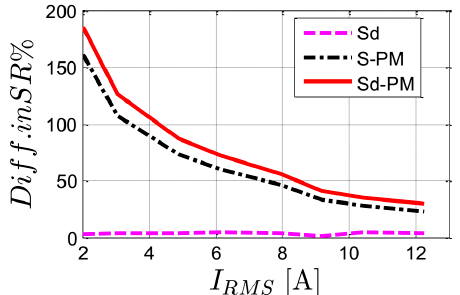
Figure 10. Difference in the saliency factor % ( SR ) as a function of stator current ( RMS ) with respect to the S machine at the optimal current angles and rated speed of the SynRMs.